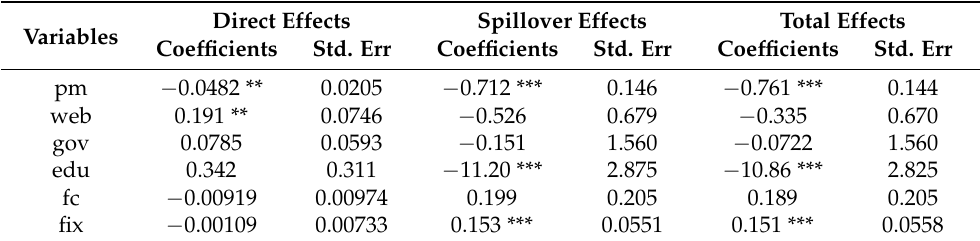
Table 8. Robust test with the second-order lagged value of air